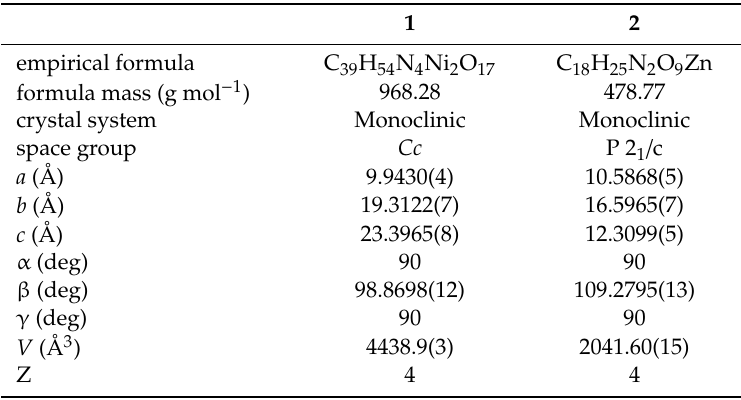
Table 1. Crystal data and refinement details of compounds 1 and 2